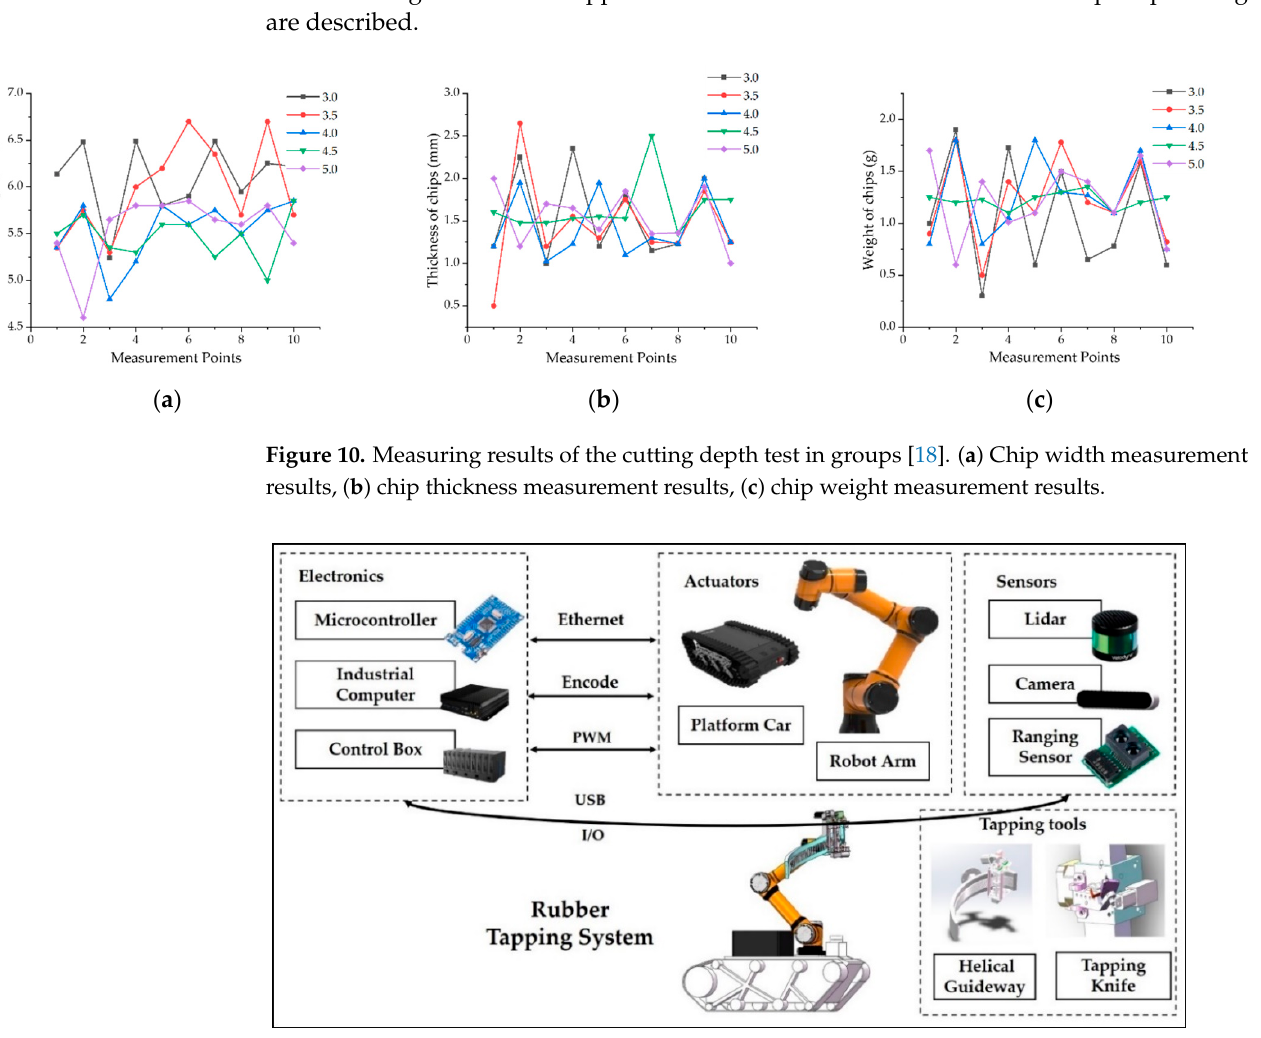
Figure 10. Measuring results of the cutting depth test in groups [18]. ( a ) Chip width measurement results, ( b ) chip thickness measurement results, ( c ) chip weight measurement results.